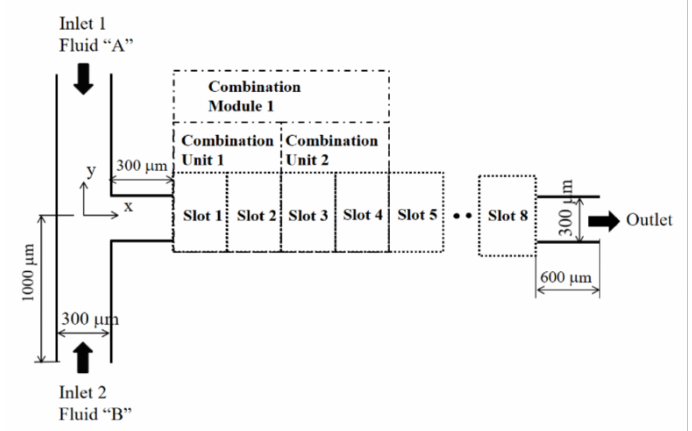
Figure 1. Diagram of a combined micromixer with eight slots (nonproportional).